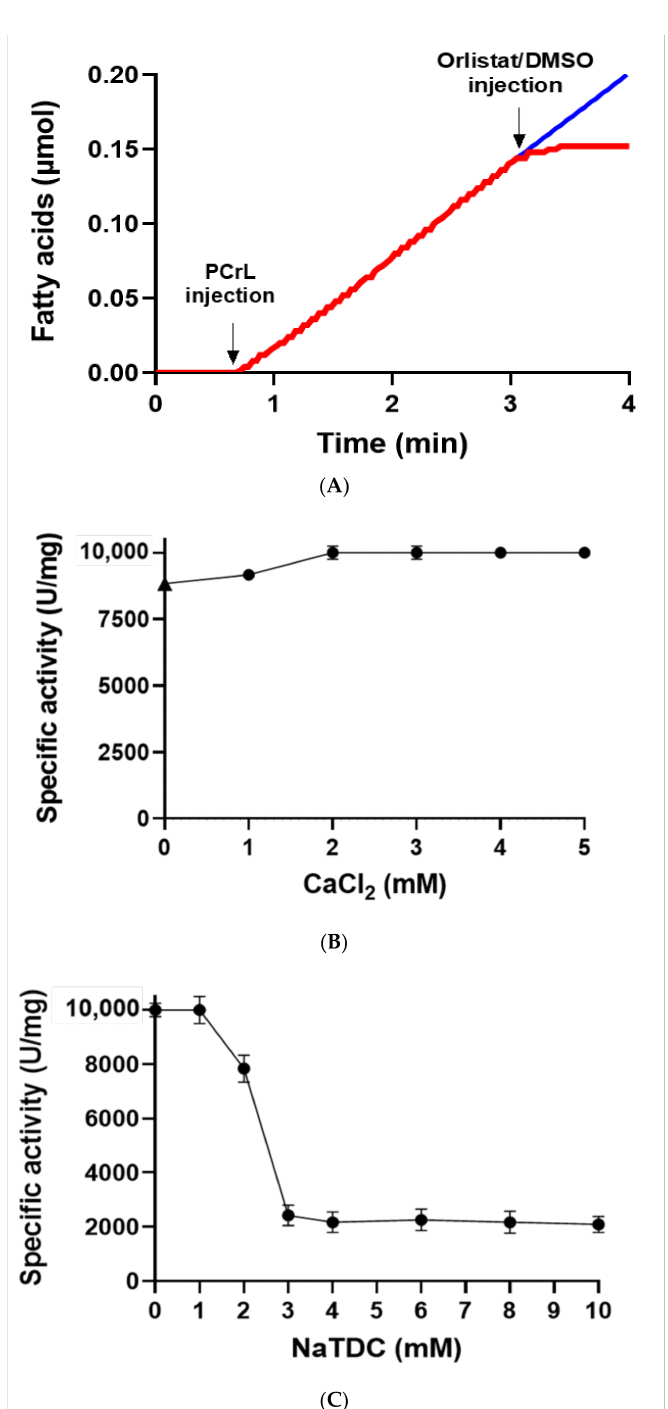
Figure 5. Influence of Orlistat, calcium, and sodium taurodeoxycholate on the PCrL activity. ( A ) Effect of Orlistat on PCrL activity. After PCrL injection, DMSO (blue line) or Orlistat in DMSO (53 µ M final concentration, red line) were injected into the reaction medium during lipolysis 3 min after starting the reaction. Curves are representative of three independent experiments. ( B ) Effect of the concentration of Ca 2+ on PCrL activity. Enzyme activity was measured at increasing concentrations of Ca 2+ using TC8 as the substrate at 37 ◦ C and pH 9. The triangle indicates the lipase activity measured in the absence of Ca 2+ and in the presence of 10 mM EDTA. ( C ) Effect of an increasing concentration of bile salt (NaTDC) on lipase activity (filled circle) in the presence of 2 mM of Ca 2+ using TC8 as the substrate at 37 ◦ C and pH